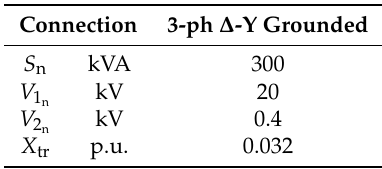
Table A1. Characteristics of the MV/LV transformer (nodes